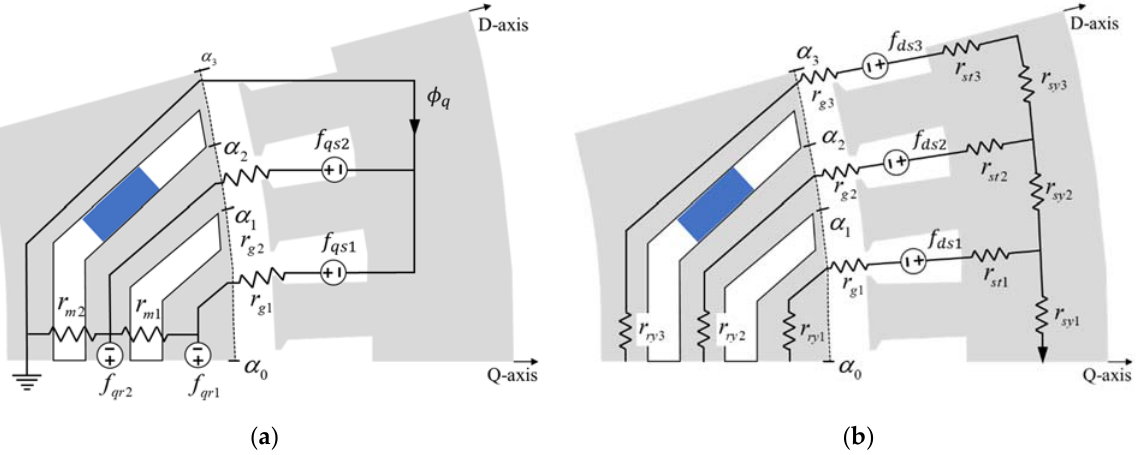
Figure 3. Magnetic equivalent circuit for ( a ) Q-axis current ( b ) D-axis current.